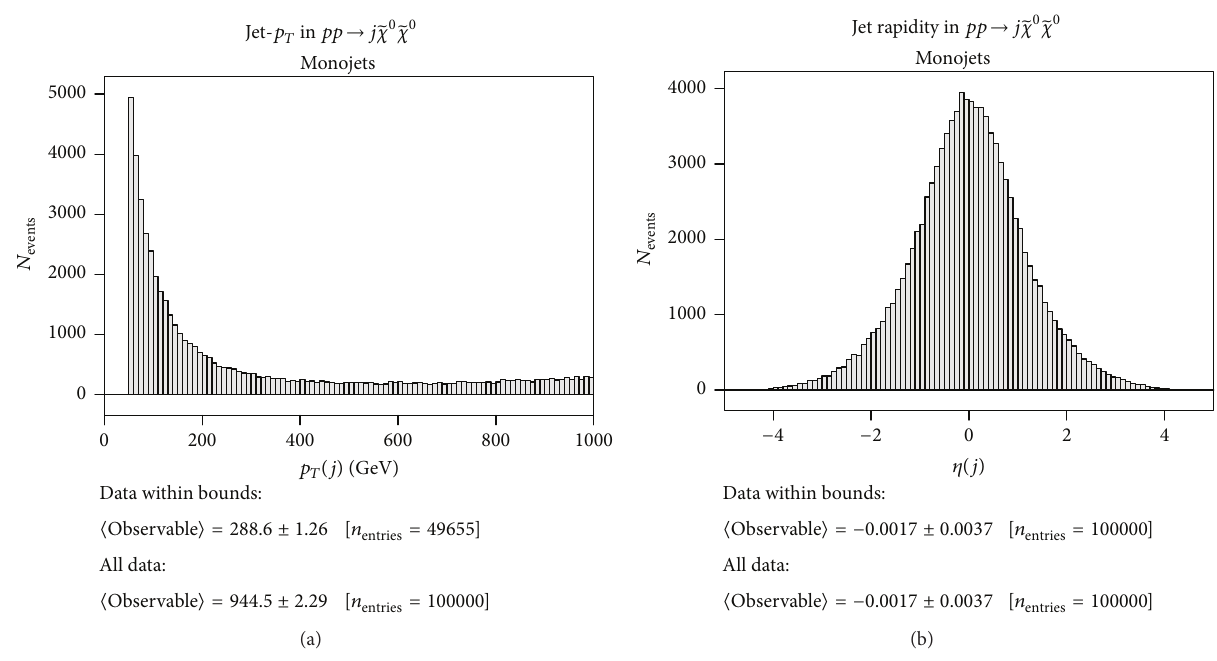
Figure 9: Plots produced by WHIZARD for the monojet event 𝑝𝑝 → 𝑗̃𝜒 0 1 ̃𝜒 0 1 . On the left: transversal momentum distribution 𝑝 𝑇 (𝑗) , on the right: rapidity distributions 𝜂(𝑗)